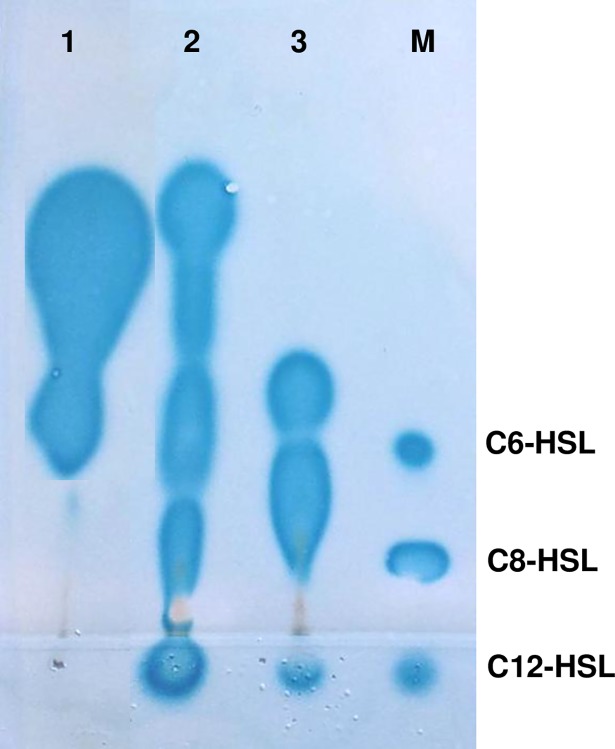
TLC analysis of the AHLs produced by Vibrio spp. using the biosensor strain Agrobacterium tumefaciens NTL4 (pZLR4).Lane 1, Vibrio coralliilyticus VibC-Oc-193; lane 2, V. mediterranei VibC-Oc-097; lane 3, V. owensii VibC-Oc-106 and lane M, synthetic AHL standards used as markers: C6-HSL (804 pmol), C8-HSL (31.6 pmol) and C12-HSL (4.8 nmol). Lanes 1 to 3 contain 25 μL of bacterial culture extract.